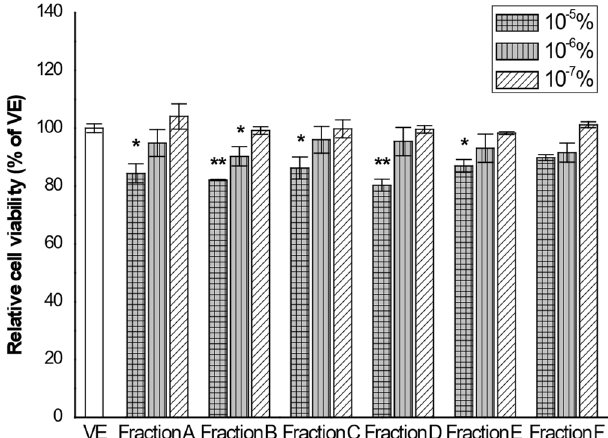
Figure 2. Effects of the six oil fractions on RBL ‐ 2H3 cell viability. RBL ‐ 2H3 cells were seeded in 96 ‐ well plate and treated with a series of concentration of the six oil fractions (10 − 5 , 10 − 6 , and 10 − 7 %) for 24 h. Cell viability was assessed by cell counting kit ‐ 8 assay. VE: vehicle, DMSO. The results